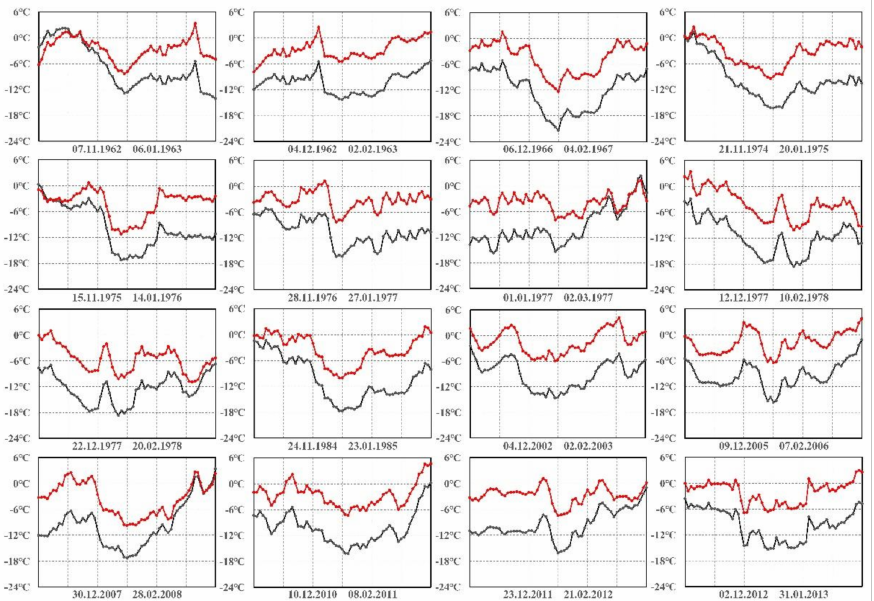
Figure 3. The evolution of regional mean temperature in the key area of 16 WPECEs (unit: ◦ C). The black line is the temperature absolute values, and the red line is the temperature anomaly.